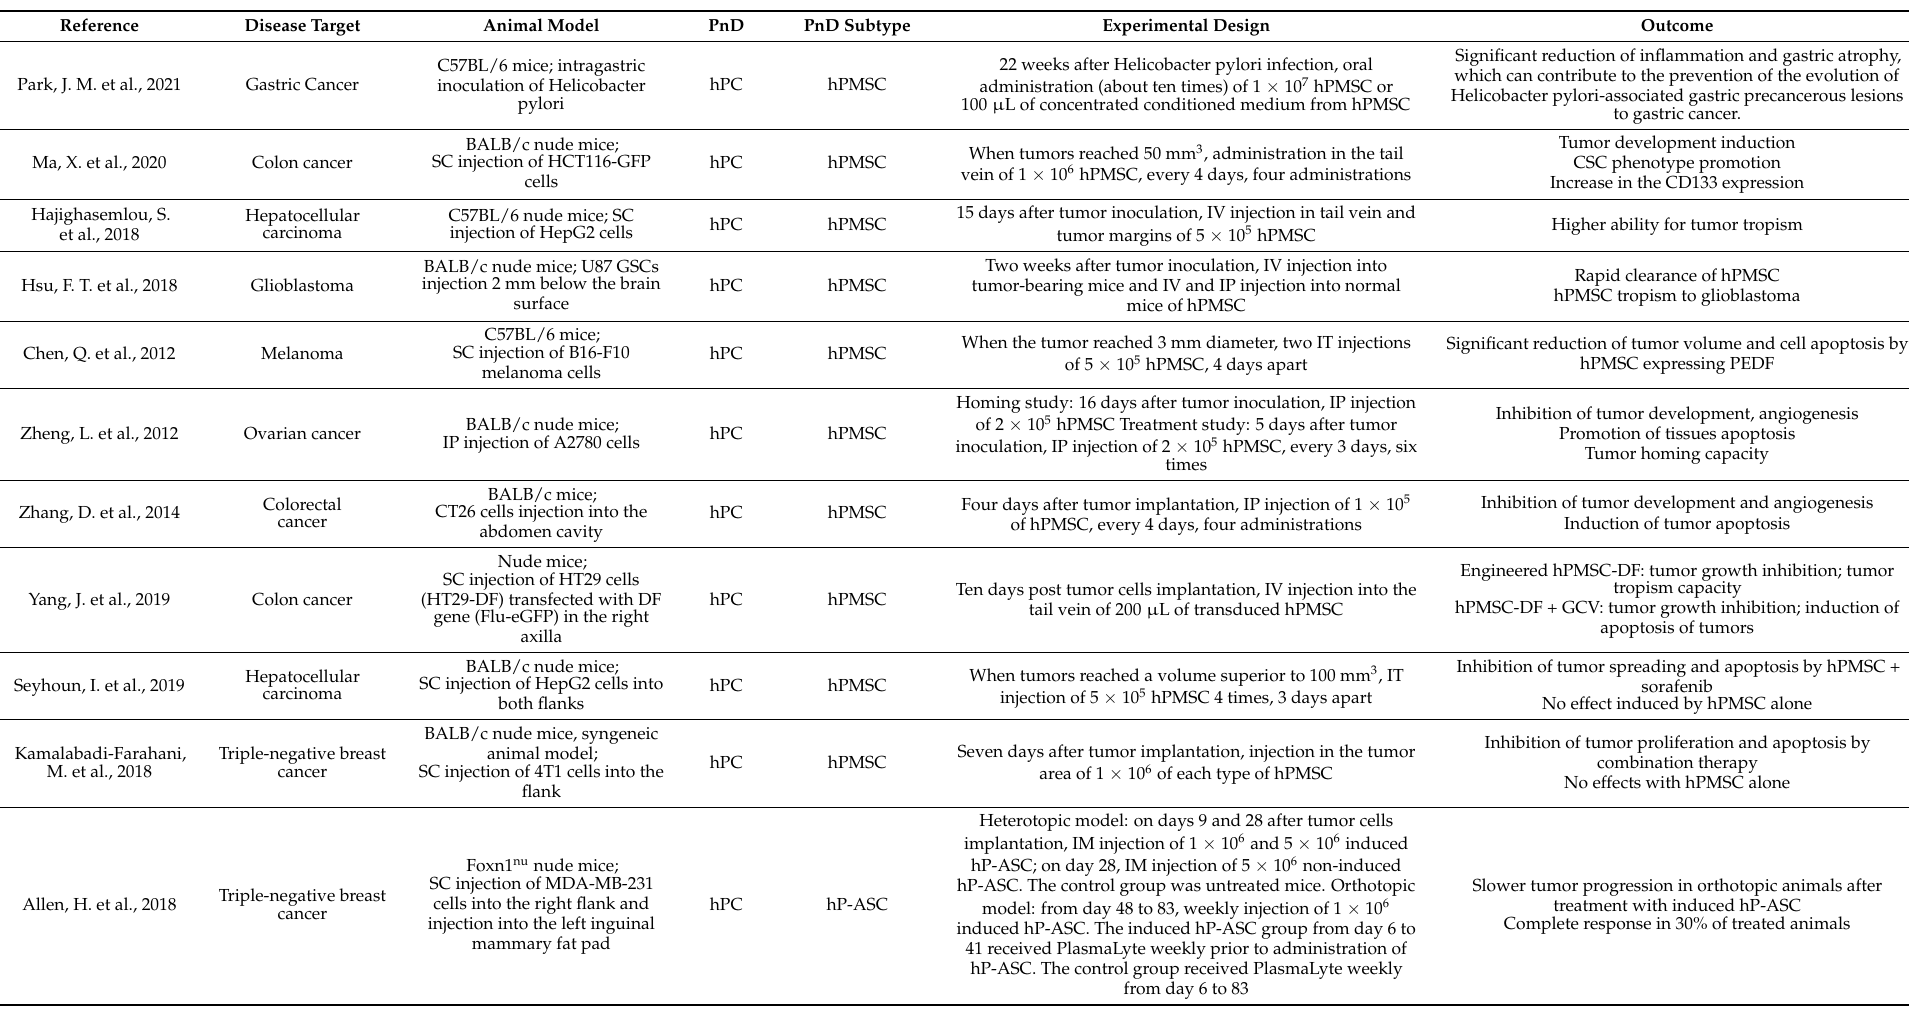
Table 1. In vivo studies of PnD application on oncological animal